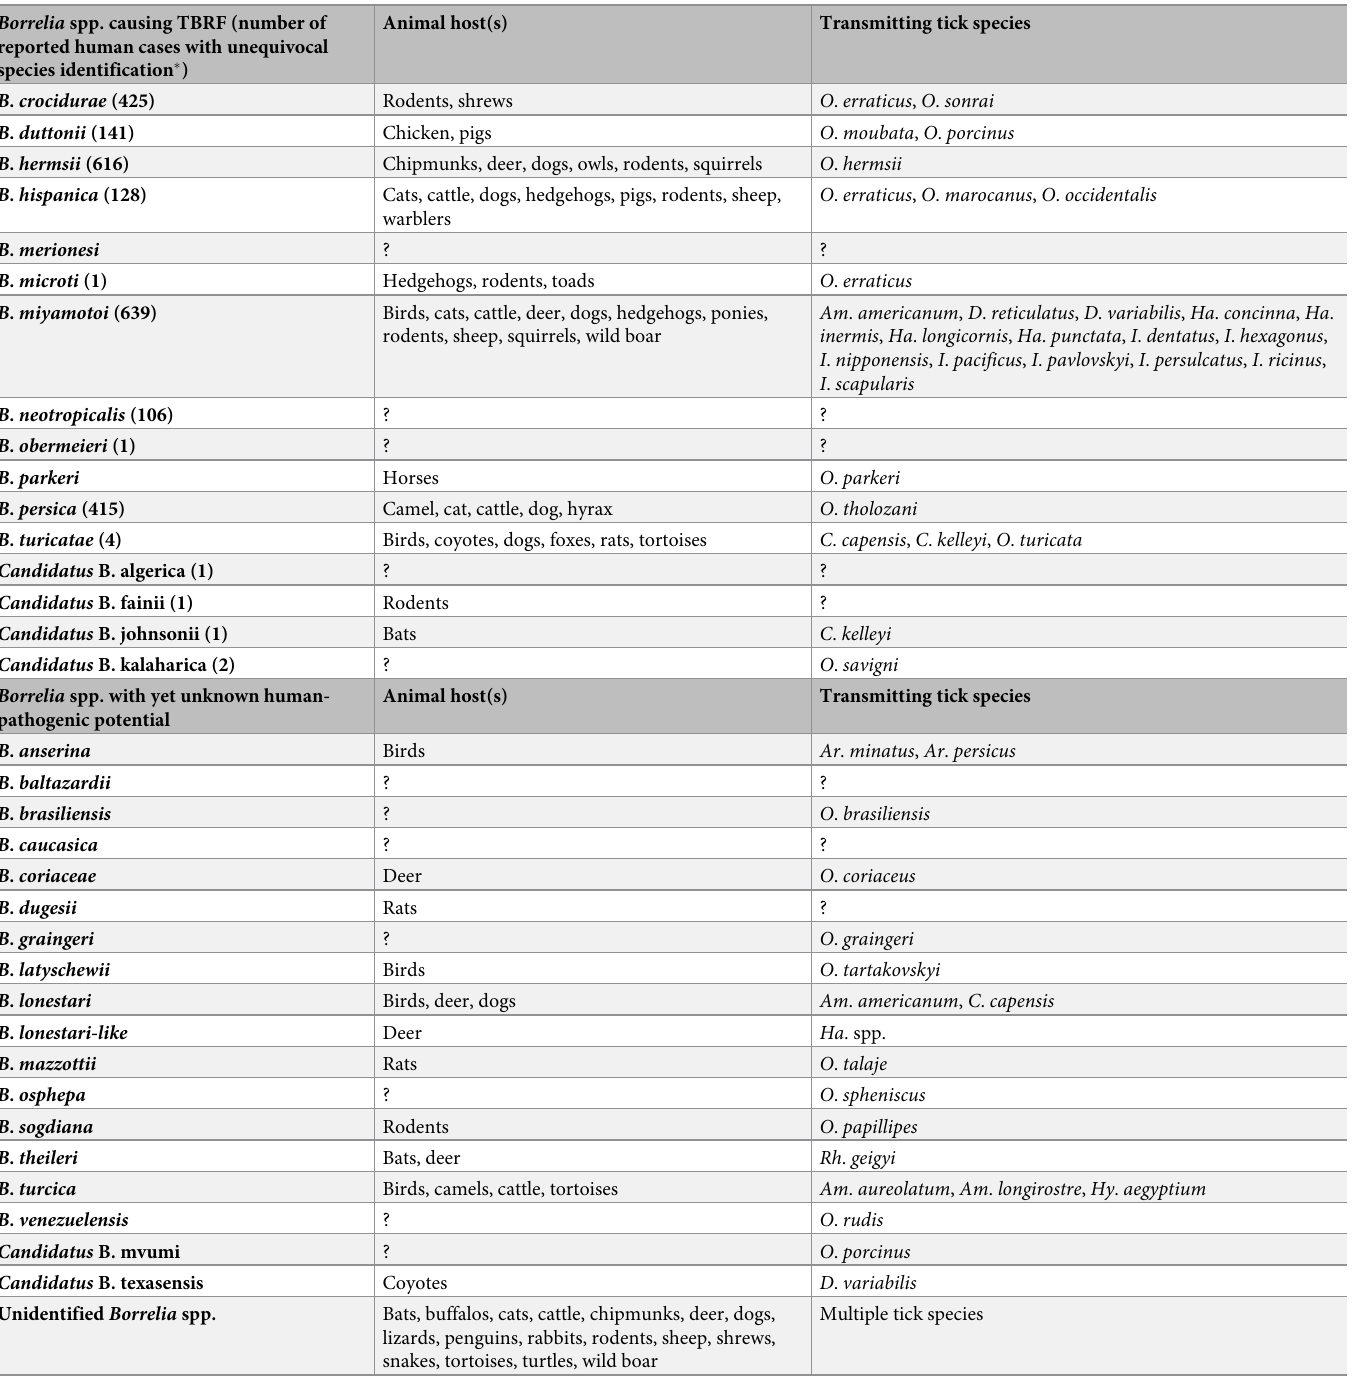
Table 3. Known and putative TBRF Borrelia spp. and their animal host(s) and transmitting tick species. Borrelia spp. causing TBRF (number of reported human cases with unequivocal species identification �